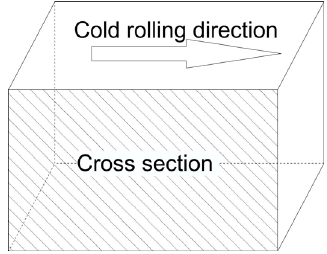
Figure 3. Cross section of longitudinal samples used in metallographic examinations.